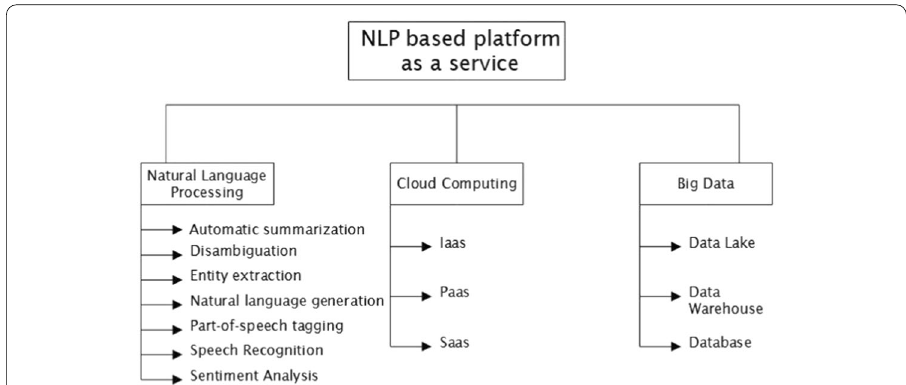
Fig. 1 An overview of NLP-based platform as a service